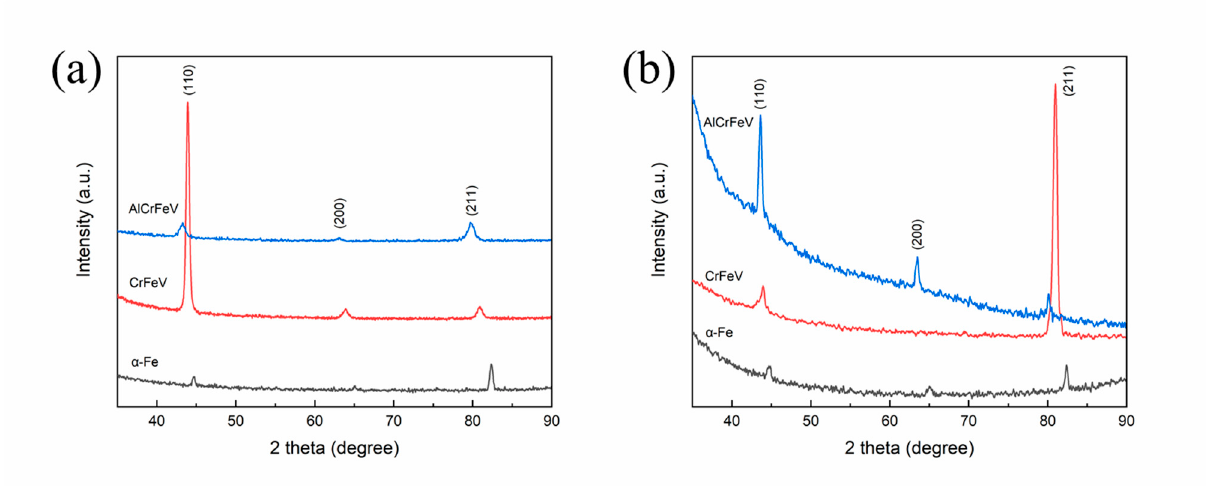
Figure 1b. Although the (200) diffraction peak of irradiated CrFeV is not obvious (because of coarse grain and irradiation induced partial atomic rearrangement), the irradiated studied materials still have bcc structures and no other phases formed. Here, the (211) diffraction peak is obviously higher than others, showing texture of another orientation in the irradiated CrFeV sample.